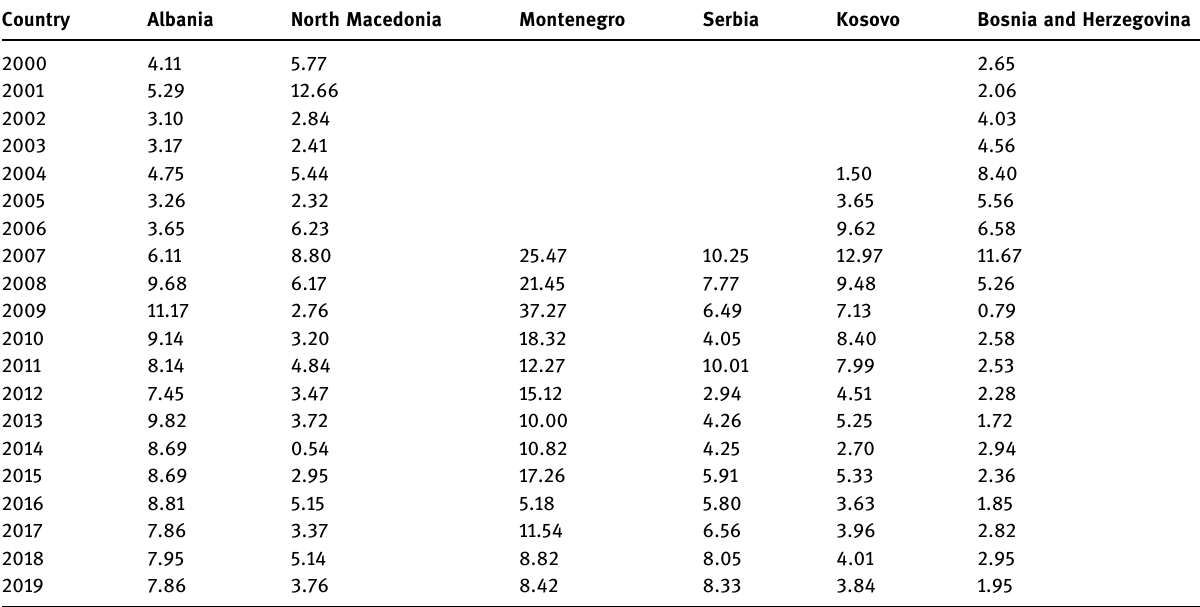
Country Albania North Macedonia Montenegro Serbia